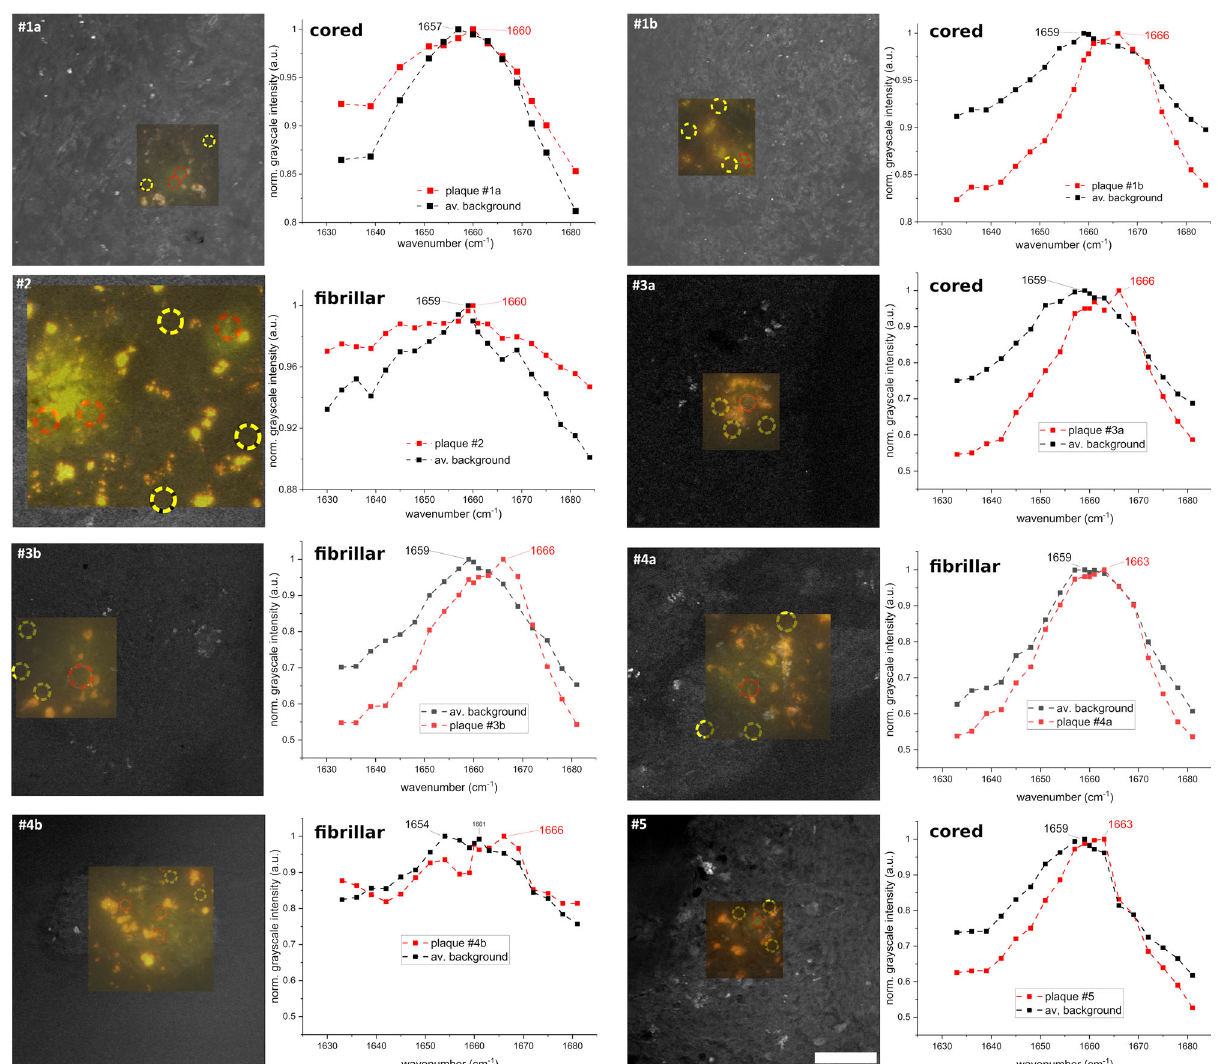
Fig. 7 SRS images obtained while scanning across the protein peak for each plaque. Auto- fl uorescence images overlaid on SRS max. intensity projection images (@ 1666 cm − 1 ) with the plaque locations shown as green spots. Next to the images are the SRS response graphs of averaged sweeps across the protein peak per plaque. A clear shift from the “ normal ” 1659 cm − 1 protein peak towards the beta-sheet peak at 1666 cm − 1 is only observed in plaques featuring a dense cored plaque. This shift was not observed in the plaque #2 and less visible in #1a (which was measured with bigger step sizes). The yellow circles indicate areas where data were taken for the background and the red circles indicate the areas for plaques. Scale bar: 50 µ